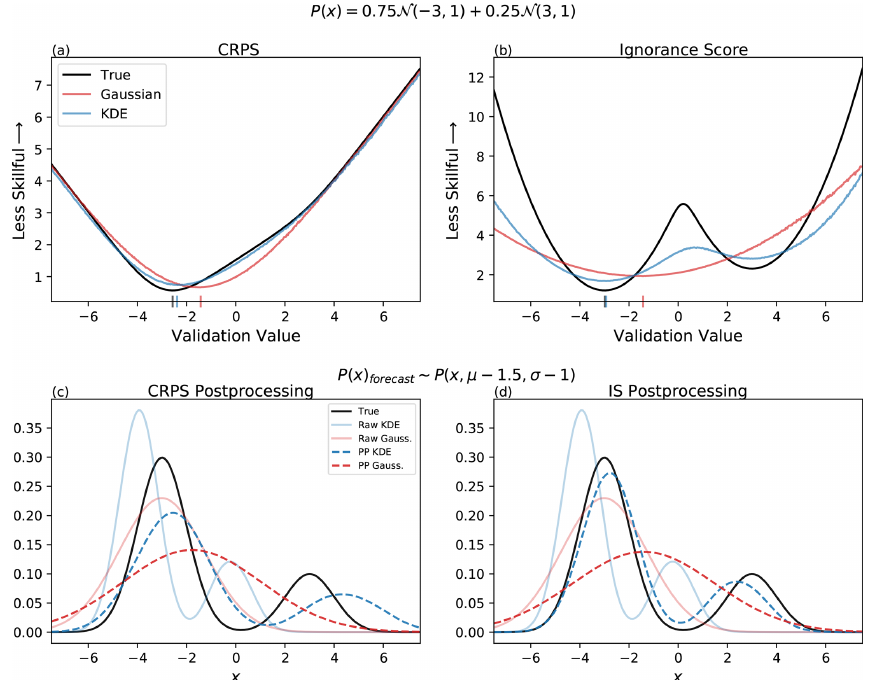
Figure 9. The comparison of two skill-scoring methods, CRPS and IS, as well as Gaussian and KDE dressing methods. The underlying distribution that 50-member samples were repeatedly drawn from is listed at the top. (a, b) The validation value is representative of what these 50 sized samples were scored against using the respective skill-scoring method. Lower scores are representative of higher skilled ensembles. Ensembles dressed with a Gaussian distribution are in red. Ensembles dressed with a KDE are in blue. Score values evaluated using the true underlying distribution are shown in black. Absolute minimum values for each distribution are demarcated with dashes on the x axis. (c, d) How using CRPS and IS to postprocesses ensembles affects the ability of a biased forecast distribution to be corrected towards the true distribution represented in panels (a) and (b) . Postprocessed distributions are in dashed lines; raw forecast distributions are in solid